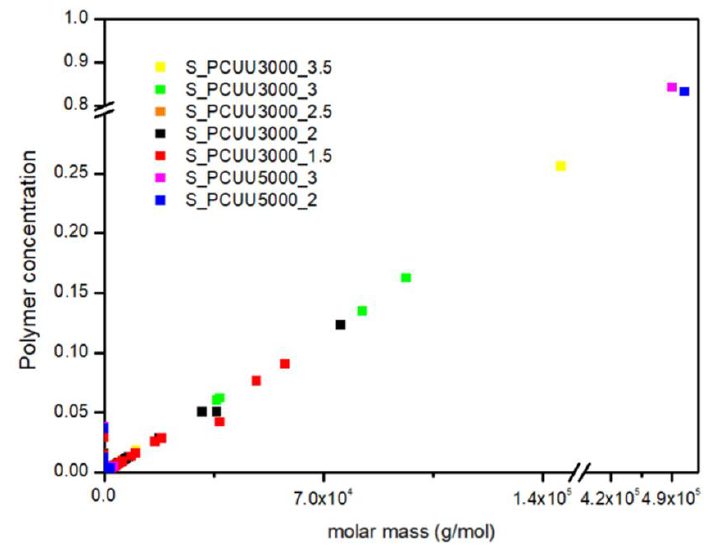
Figure 19. Polymer concentration profiles for PCUU samples based on OCD with molar masses of 3000 g × mol −1 and 5000 g × mol −1 .